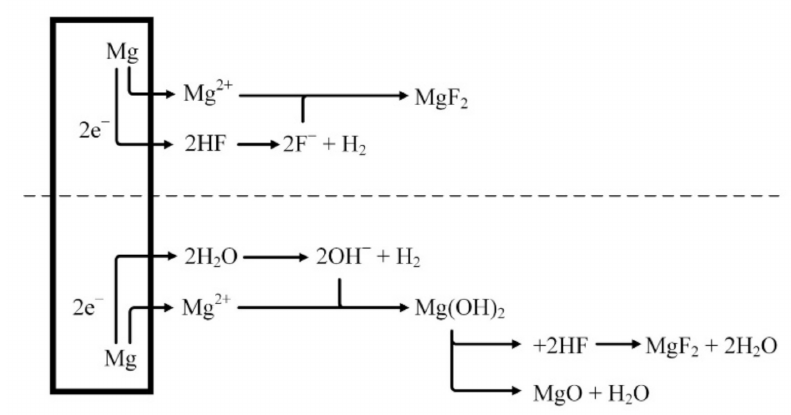
Figure 3. Schematical representation of fluoride conversion coatings on magnesium.